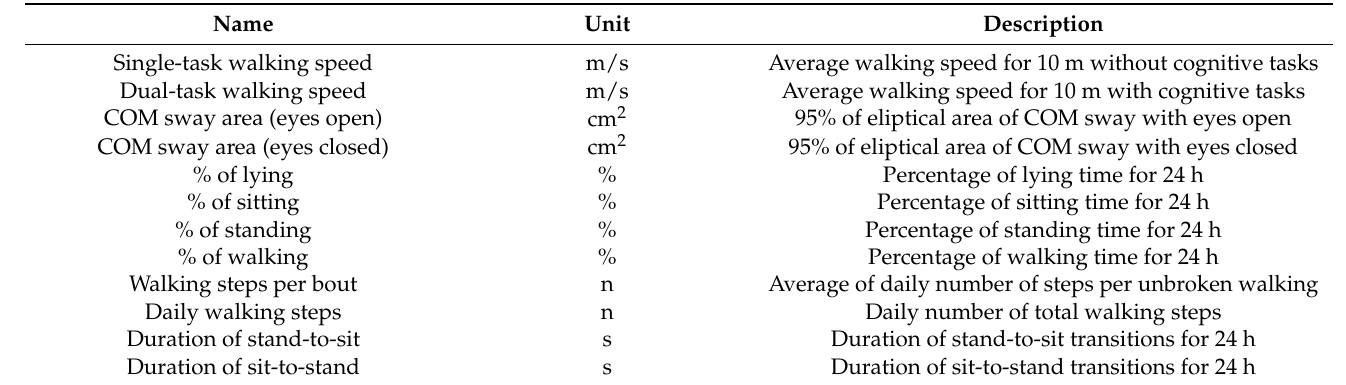
Table 1. Description of gait, balance, and physical activity